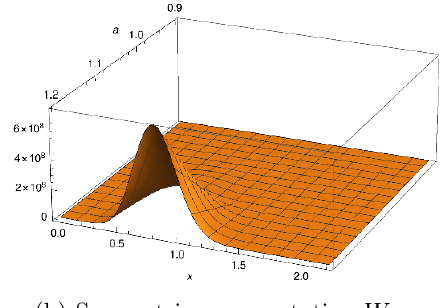
expansion from the exact (cid:12)nite N result by numerical (cid:12)tting, and some of the results